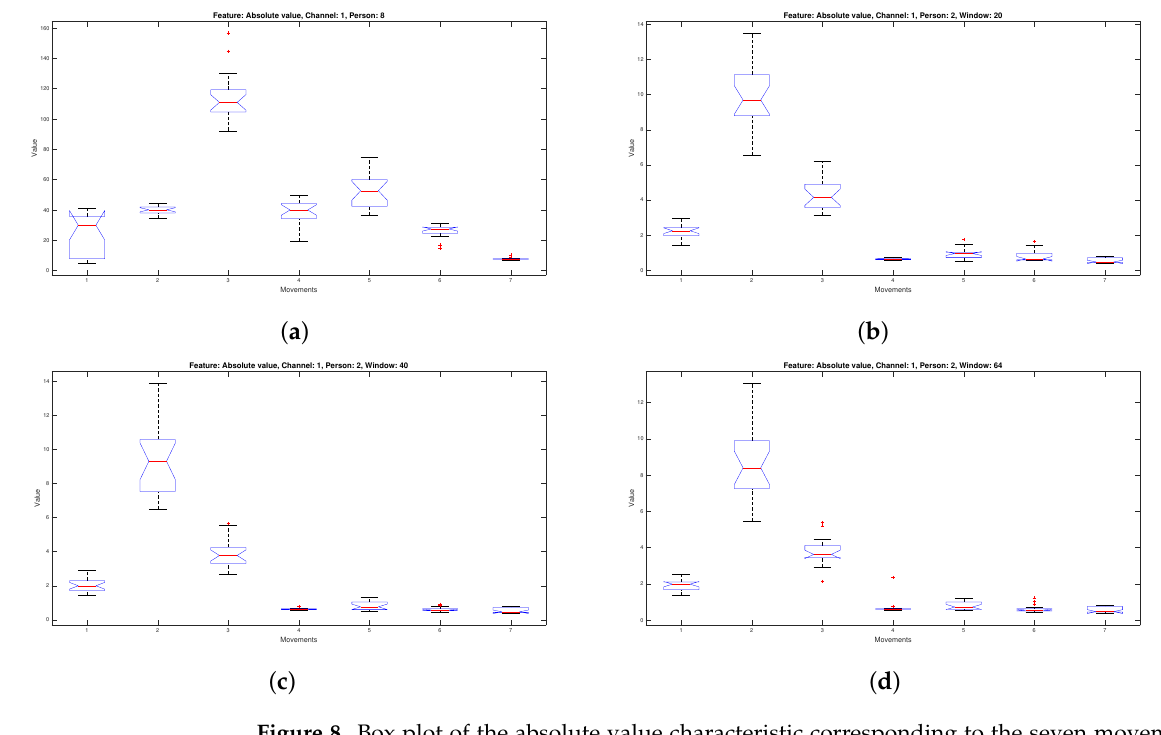
Figure 8. Box plot of the absolute value characteristic corresponding to the seven movements of channel one of person two ( a ) considering the unsegmented signal, ( b ) considering window 20, ( c ) considering window 40, and ( d ) considering window 64.